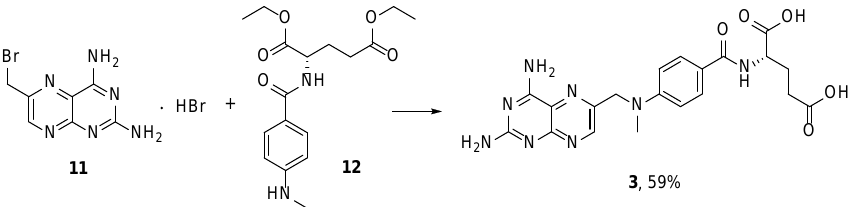
Scheme 3. Synthesis of MTX by the reaction between metal salt of p -( N -methyl)-aminobenzoyl- L - glutamic acid and 2,4-diamino-6-bromomethylpteridine hydrobromide.